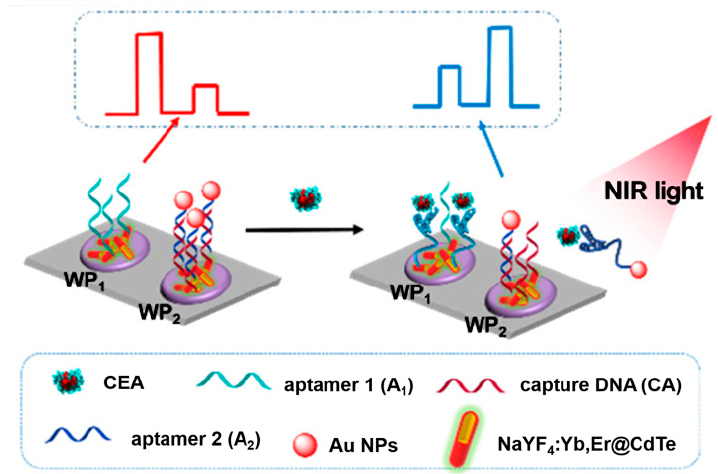
Figure 12. Construction of the up-conversion-mediated ratiometric PEC aptasensor for CEA detection. Reprinted with permission from ref. [129]. Copyright 2019 American Chemical Society. Table 4. Analytical performances of various photoelectrochemical aptasensors for CEA assays.